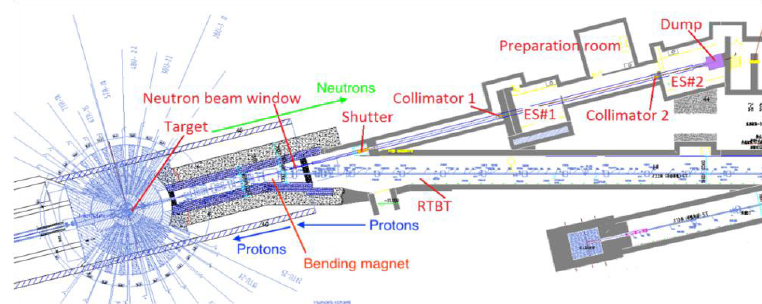
Fig.1 Layout of Back-n beam line at CSNS